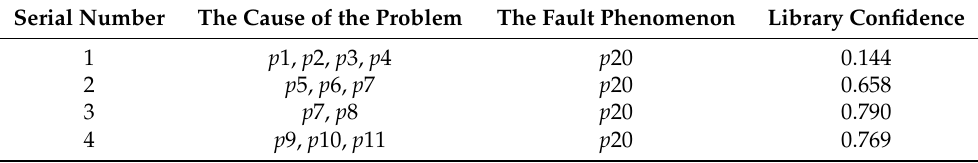
Table 3. The table of failure event place